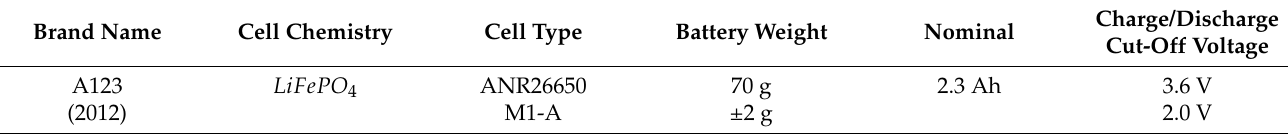
Table 3. Battery